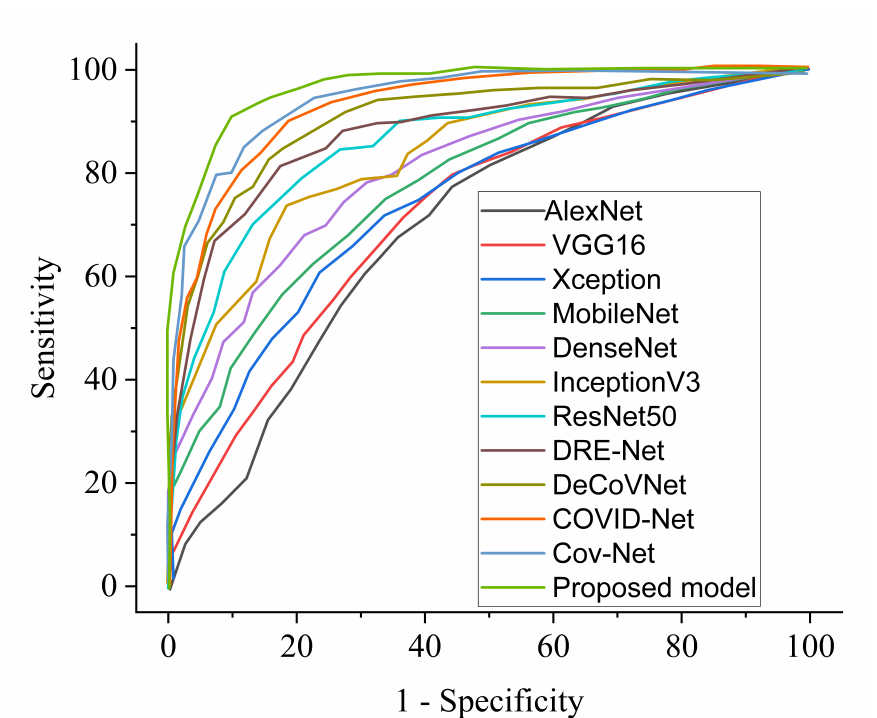
Figure 13. Performance ROC in comparison with our proposed model and other pre-trained models and selected state-of-the-art COVID-19 models for binary class.